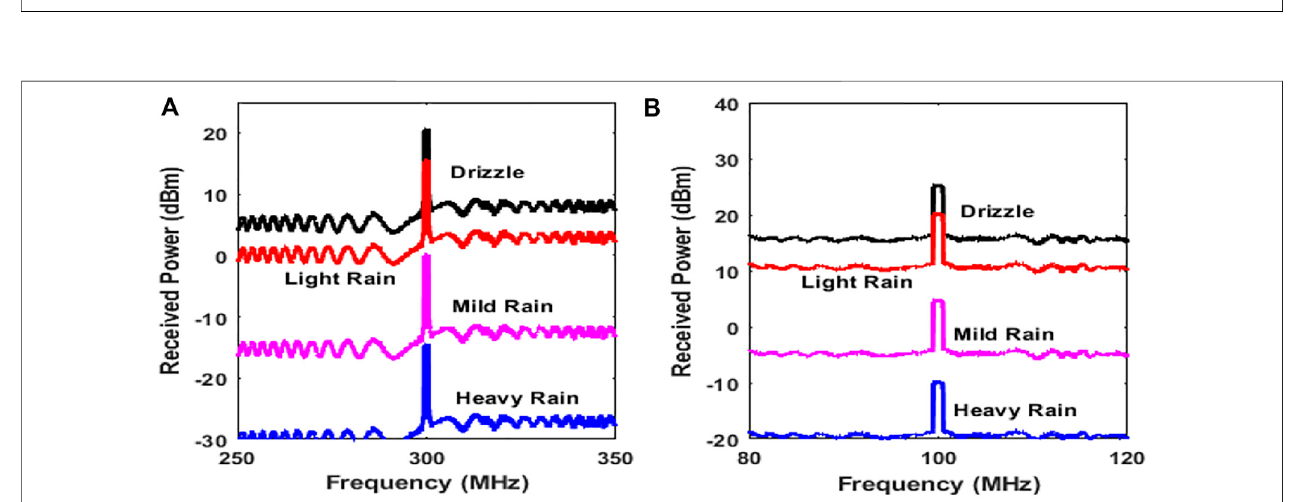
FIGURE5| Targetdetectionunderrainyweatheratrange750 m withrangefrequencyatdifferentattenuationlevelswithsweeptimes (A) 10 µsec and (B) 30 µsec .